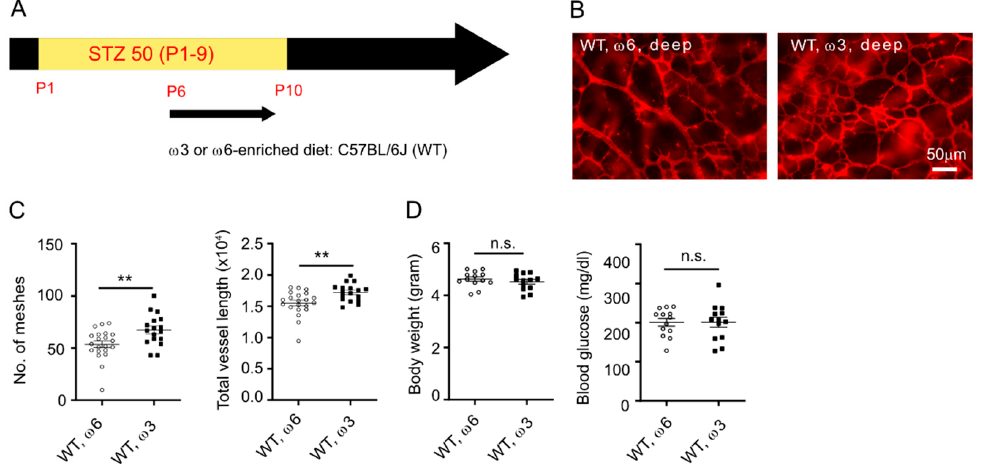
Figure 2. Dietary LCPUFA directly promoted deep retinal vessel growth in Phase I ROP. ( A ) Schematics of hyperglycemic induction in C57BL/6J mice. An amount of 50 mg/kg STZ was i.p. injected daily from P1 to P9. The mice were fed a ω -3 or ω -6 LCPUFA-enriched diet from P6 until P10 when the retinas were collected for analysis. ( B ) Representative images of deep retinal vessels in P10 C57BL/6J STZ mice fed a ω -3 or ω -6 LCPUFA-enriched diet. Retinal vessels were stained with isolectin. Scale bar, 50 μ m. ( C ) ω -3 versus ω -6 LCPUFA-enriched diet promoted retinal vascular network formation at P10. n = 17–21 eyes. Unpaired t -test. ** p < 0.01. Data are represented as mean ± SEM. ( D ) Comparable body weight and blood glucose levels in ω -3 versus ω -6 LCPUFA-fed C57BL/6J mice. n = 13 mice. Unpaired t -test. n.s., no significance. Data are represented as mean ± SEM.